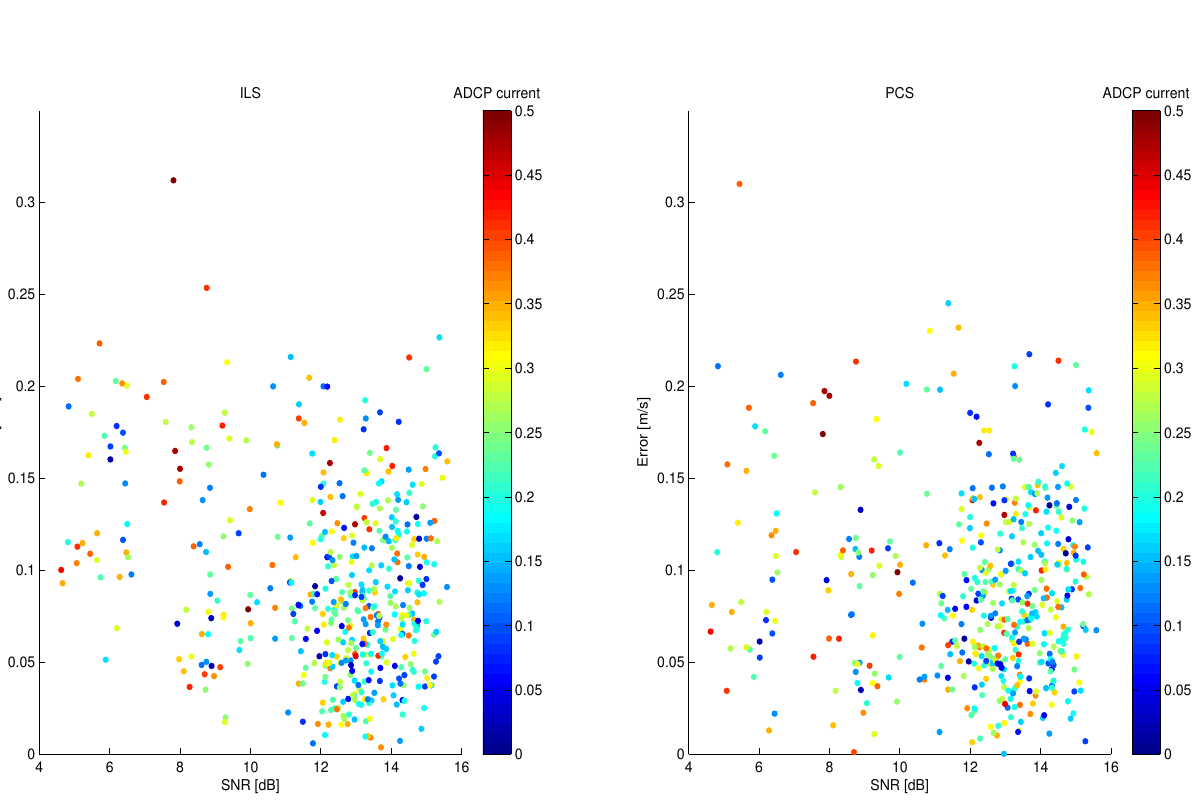
Figure 8. Significant wave height and wind speed.